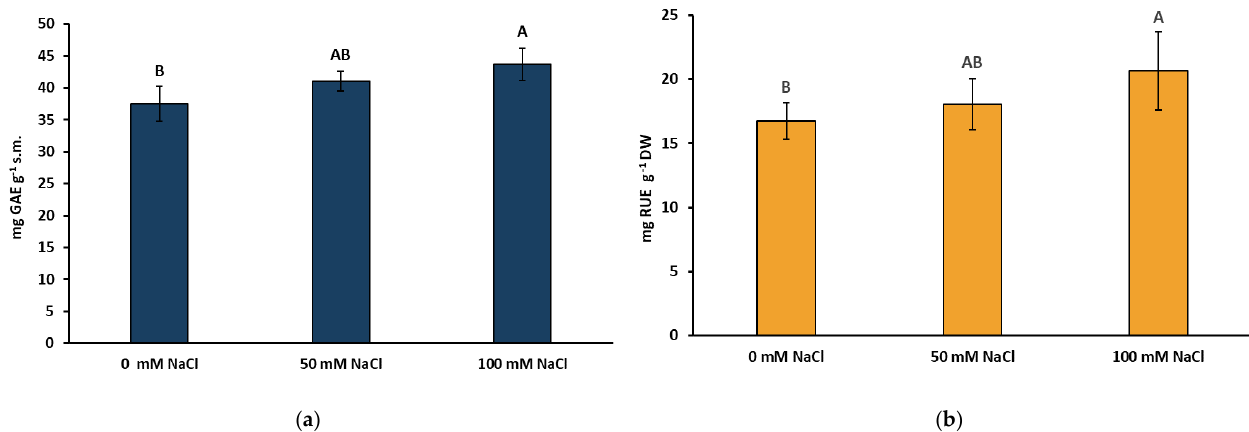
Figure 2. Effect of the NaCl concentration on the concentration of ( a ) total soluble phenolic compounds and ( b ) total soluble flavonols in Melissa officinalis shoots after 10 days of salt exposure. Data are means ± SD ( n = 4). Means followed by different letters differ statistically significantly ( p < 0.05, Tukey’s test).